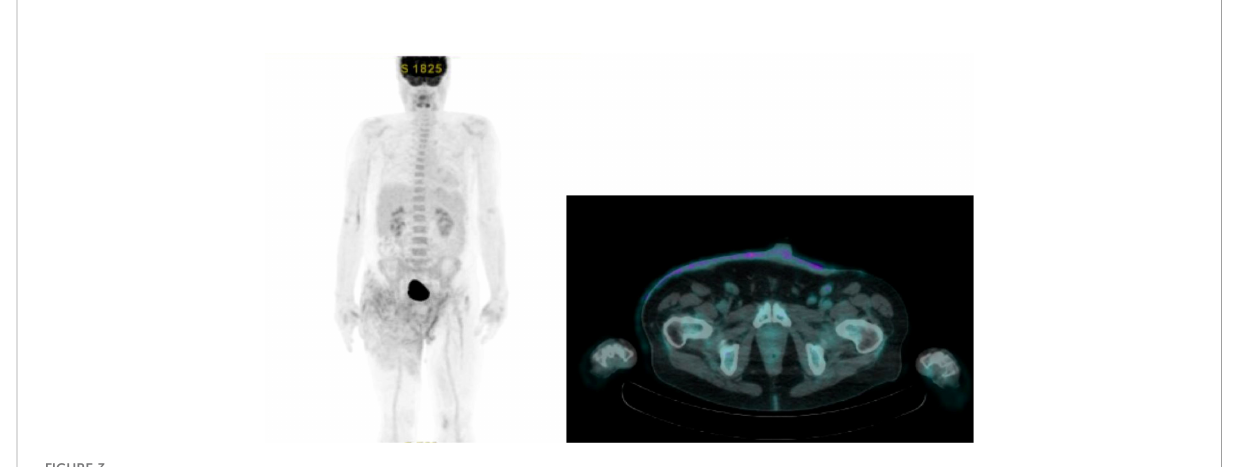
FIGURE 3 FDG PET/CT scan at baseline of patient ’ s clinical history.